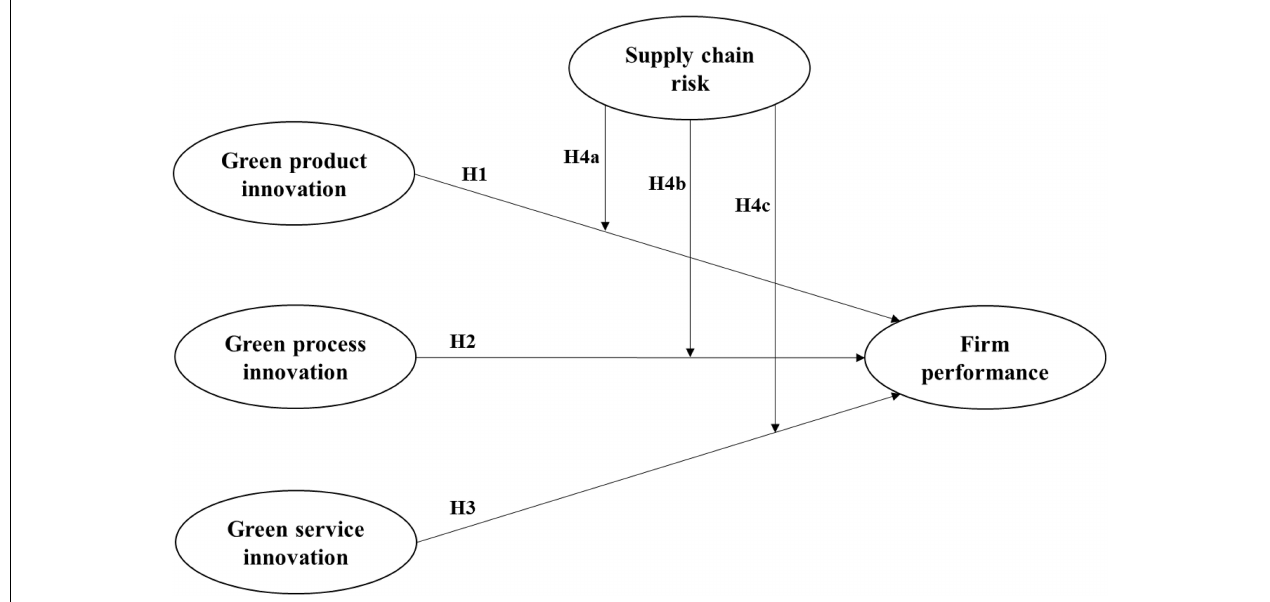
FIGURE 1 | Conceptual